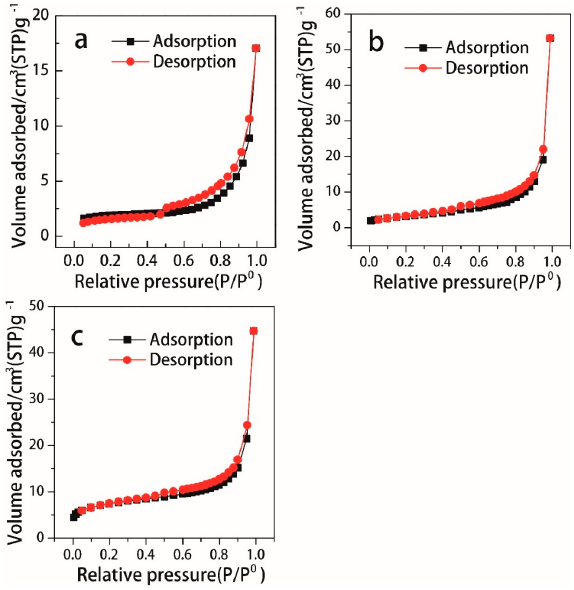
Figure 1. N 2 adsorption–desorption isotherms of ( a ) Ti 3 C 2 X 2 , ( b ) alk-Ti 3 C 2 X 2 , and ( c ) Pd/alk-Ti 3 C 2 X 2 .